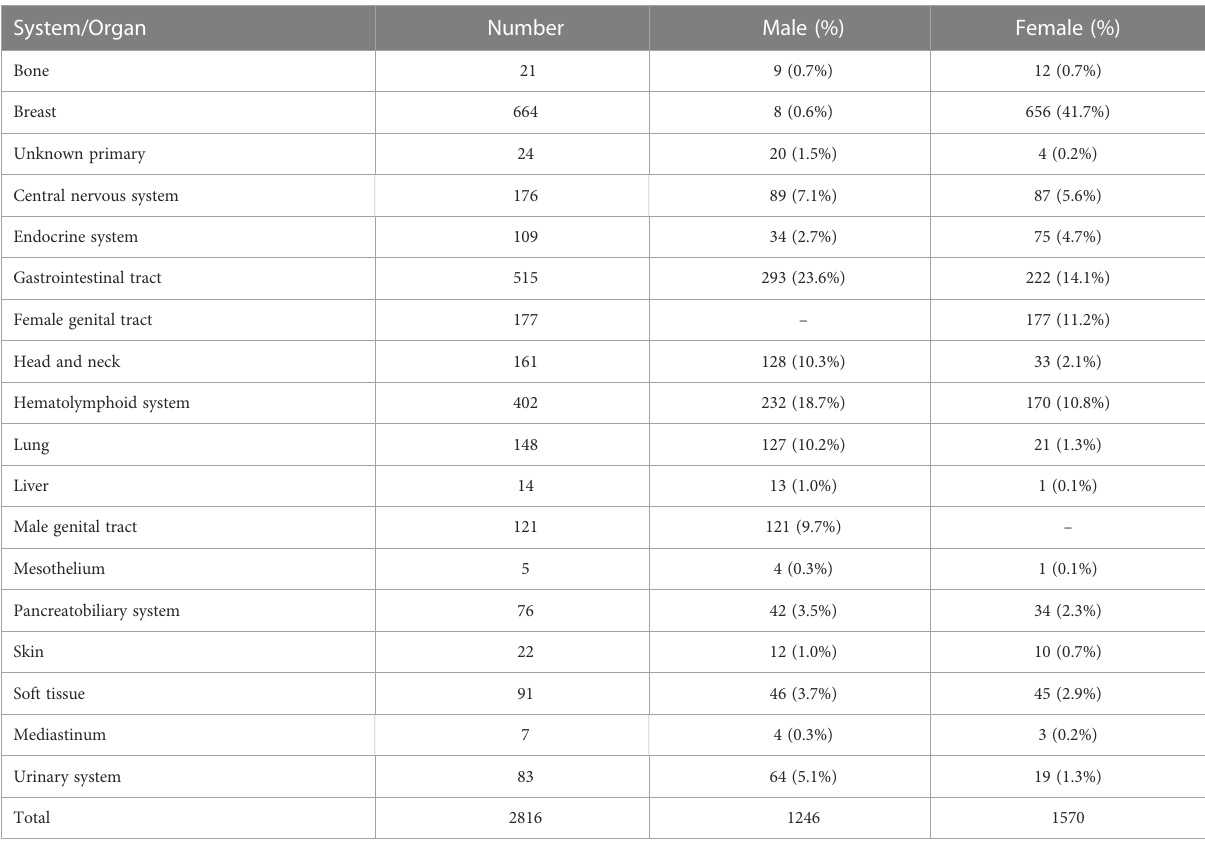
TABLE 3 Gender-based strati fi cation of adult tumors.